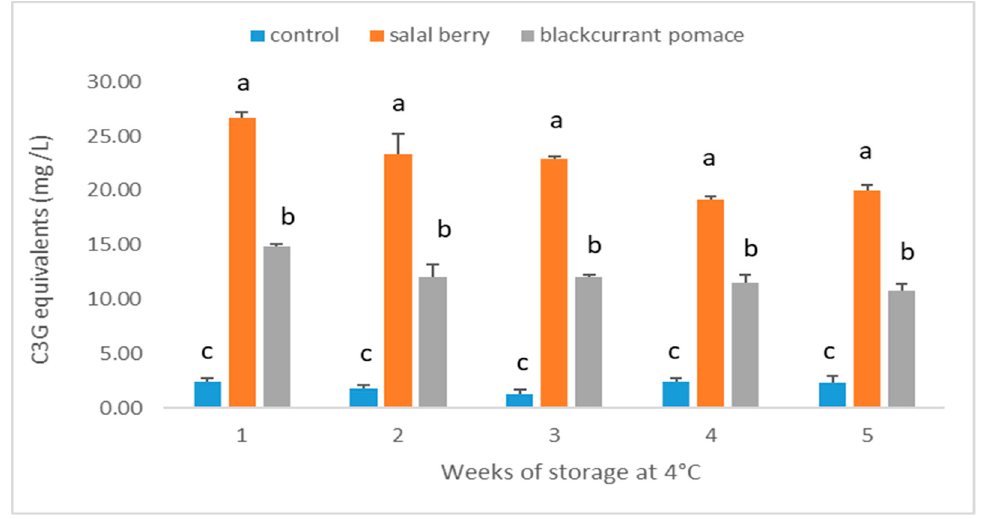
Figure 3. Total anthocyanin content of yogurt beverages during cold storage. Results are presented as means ± SD. Different low case letters denote significant differences at each time point ( p < 0.05).